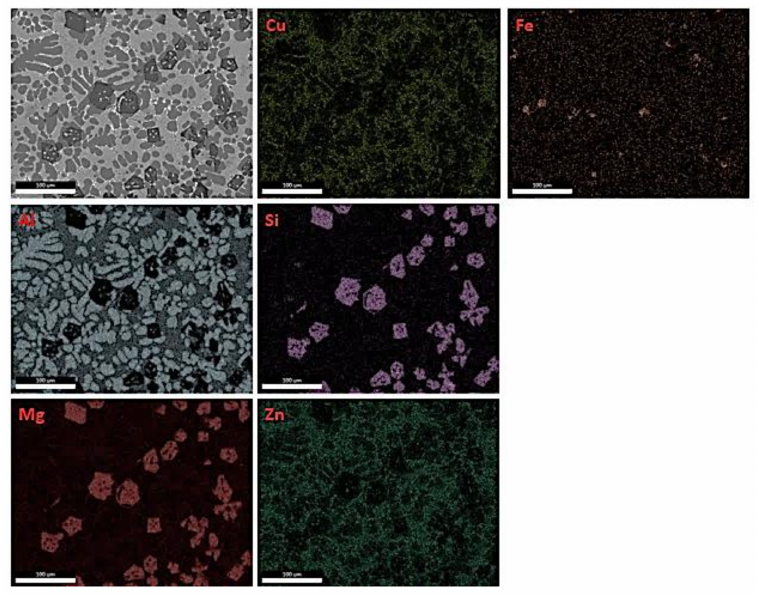
Figure 8. EDS map of 1M